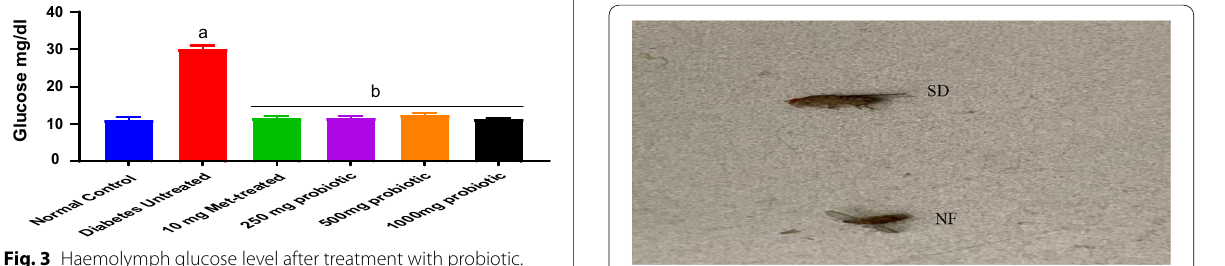
Fig. 5 Male Drosophila fly fed with sucrose diet (SD) at the top versus normal fly fed with standard feed below